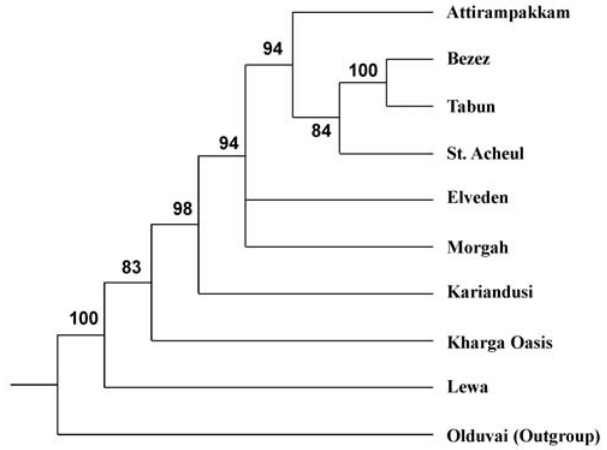
Figure 2. 50% majority-rule consensus bootstrap tree (based on 10,000 bootstrap iterations).